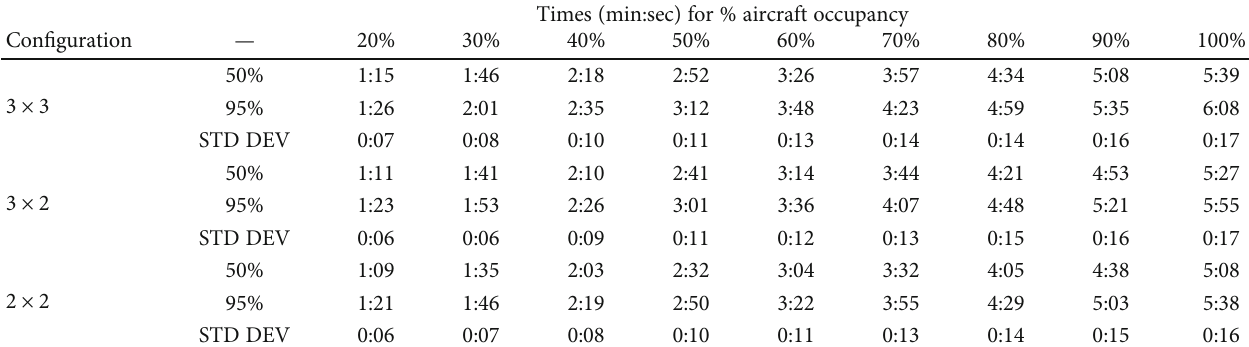
Table 8: Complete comparison of deboarding times for the three aircraft con fi gurations for di ff erent % of aircraft occupancy. Times (min:sec) for % aircraft occupancy Con fi